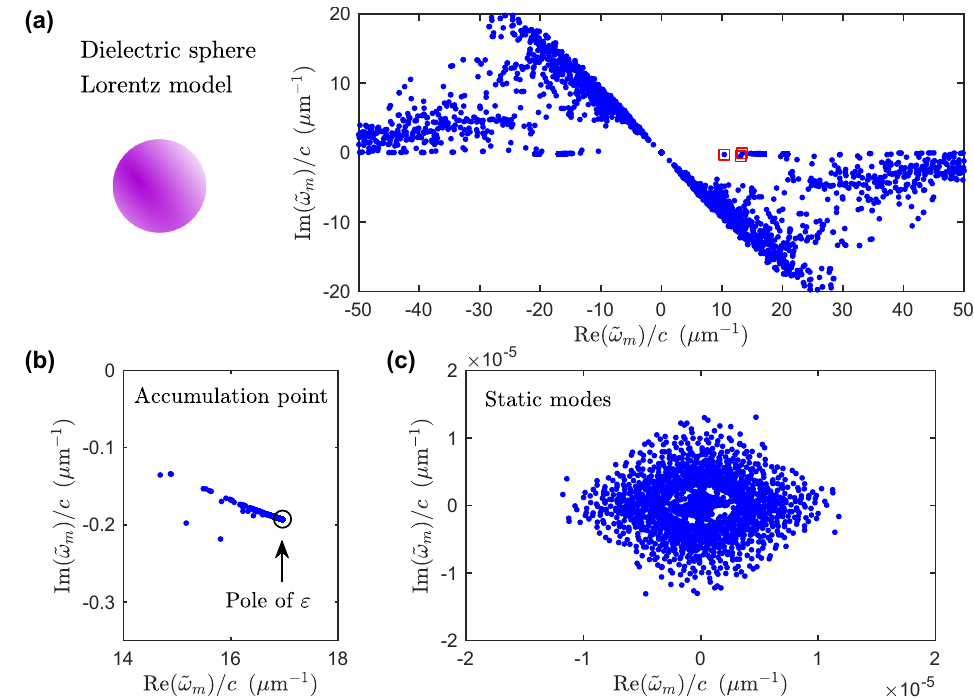
Figure 3. Complex QNM frequencies for a dielectric sphere with a Lorentz permittivity. ( a ) Full eigenvalues spectrum computed with the QNM solver. Red squares show the three QNMs responsible for the resonances in the spectral range of interest. ( b ) Eigenvalues forming an accumulation point (cid:113) − γ 2 /4 − i γ /2 of the permittivity. ( c ) Cloud of eigenvalues close to the origin ω 2 at the pole ω = 0 that correspond to static modes.